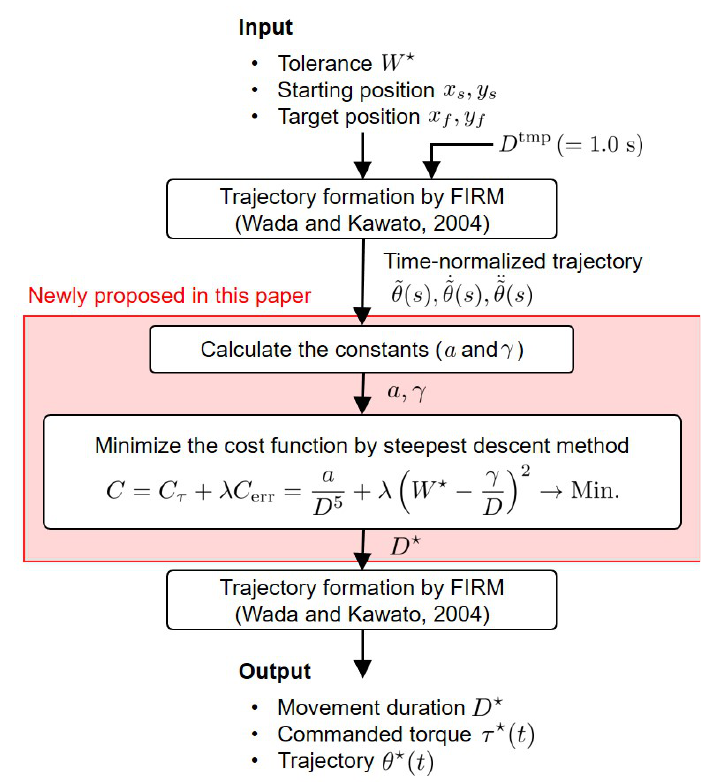
Figure 1. Schematic diagram of proposed computational models in point-to-point human arm reaching movement. The parts newly proposed in this paper are shown in a red